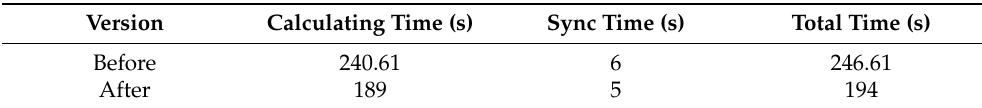
Table 2. Comparison test before and after